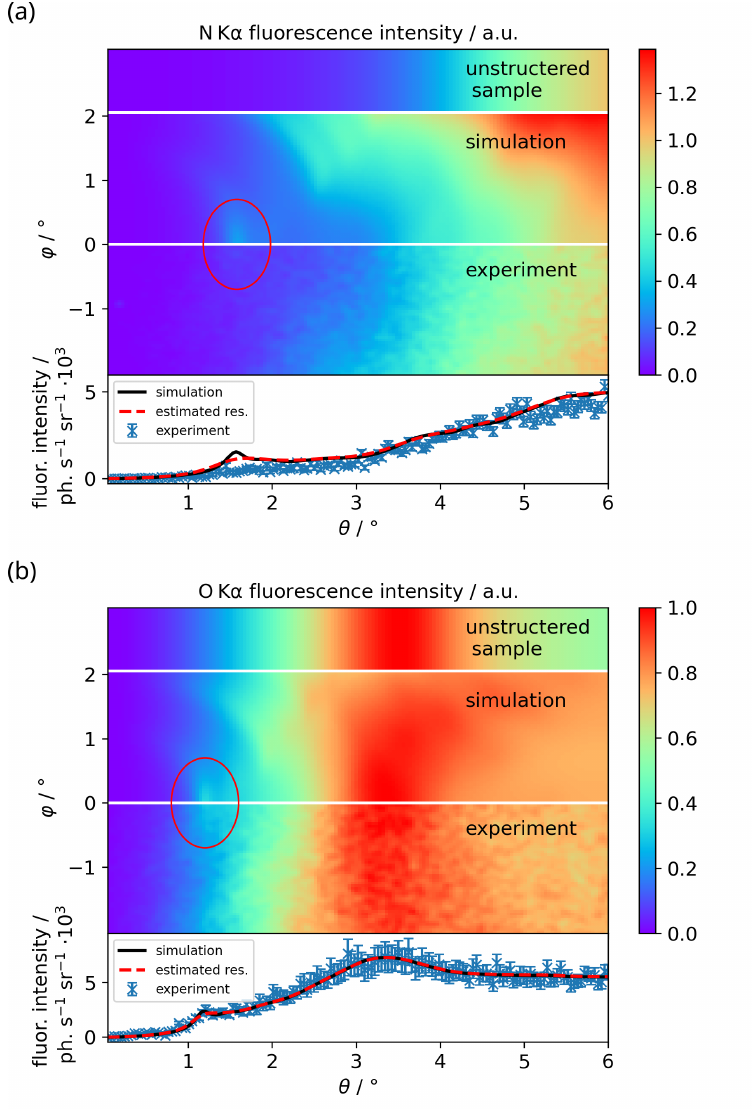
Figure 5. Measured and simulated θ - ϕ -maps and θ -profiles from the Si 3 N 4 lamellar grating recorded with the laboratory SF-GEXRF spectrometer utilizing the LPP source. Notation and figure structure are as in Figure 3. For computing the SF-GEXRF profile at ϕ = − 0.02°, the ROI method is used due to low counting